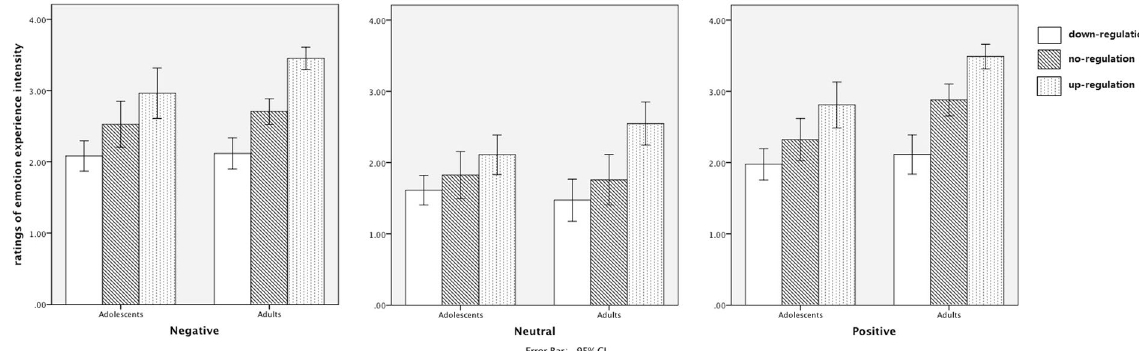
Figure 2. Behavioral results for different experiment condition between adolescents and